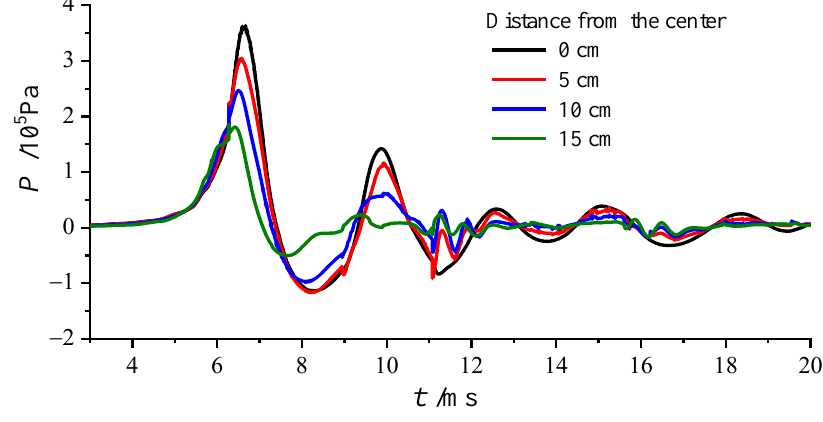
Figure 10. Slamming pressure at different positions of the bottom.